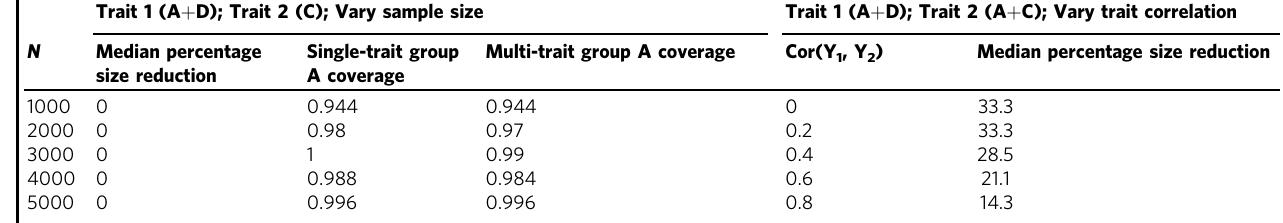
When traits share a causal variant, fl ashfm tends to yield smaller SNP groups than those from single-trait fi ne-mapping, regardless of amount of missing data and trait correlation; both methods have similar resolution and accuracy when there are no shared causal variants. In simulations with a shared causal variant A, (trait 1 is A + D, trait 2 is A + C), β A = log(1.4) for both traits 1 and 2; trait 1 has a second causal variant D and trait 2 has second causal variant C, both with β = log(1.25). In the non-shared causal variant setting (A + D, C), all causal variants have β = log(1.25). Traits 1 and 2 have correlation 0.4 and were both measured on all individuals, unless otherwise speci fi ed. When proportion missing data and trait correlation vary, sample size is 3000. The region has 345 SNPS and was simulated to mimic the LD structure of the IL2RA region, 10p-6030000-6220000 (GRCh37/hg19). Results are based on 300 replications.